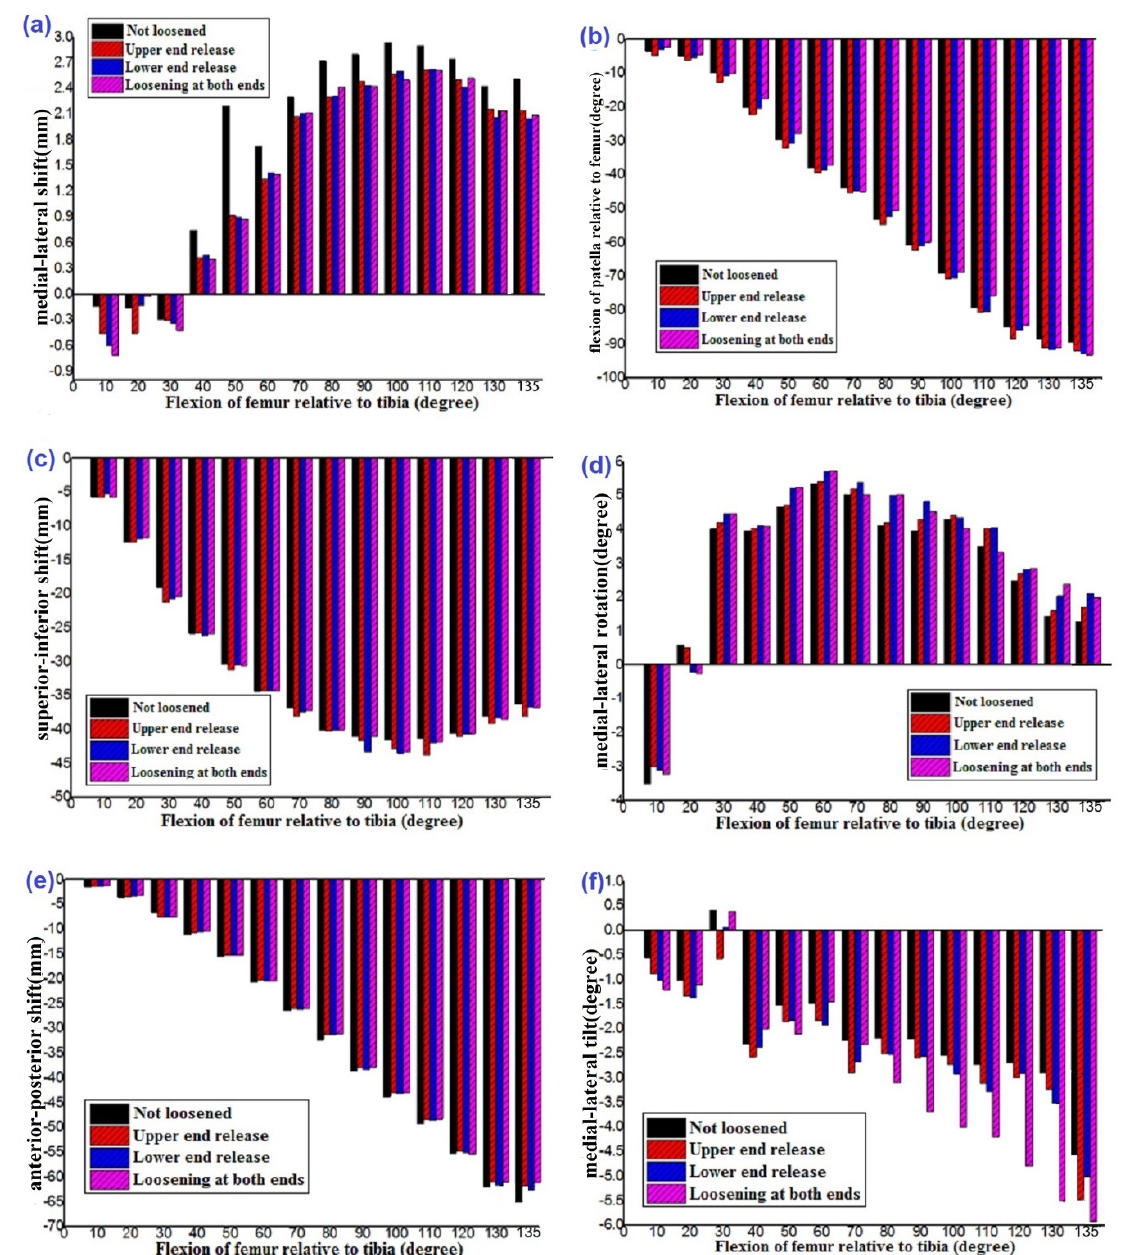
Figure 6. Patellofemoral movement data at di ff erent flexion degrees before and after the patellar tendon was released. ( a ) Medial-lateral shift; ( b ) flexion of patella relative to femur; ( c ) superior-inferior shift; ( d ) medial-lateral rotation; ( e ) anterior-posterior shift; ( f ) medial-lateral tilt.